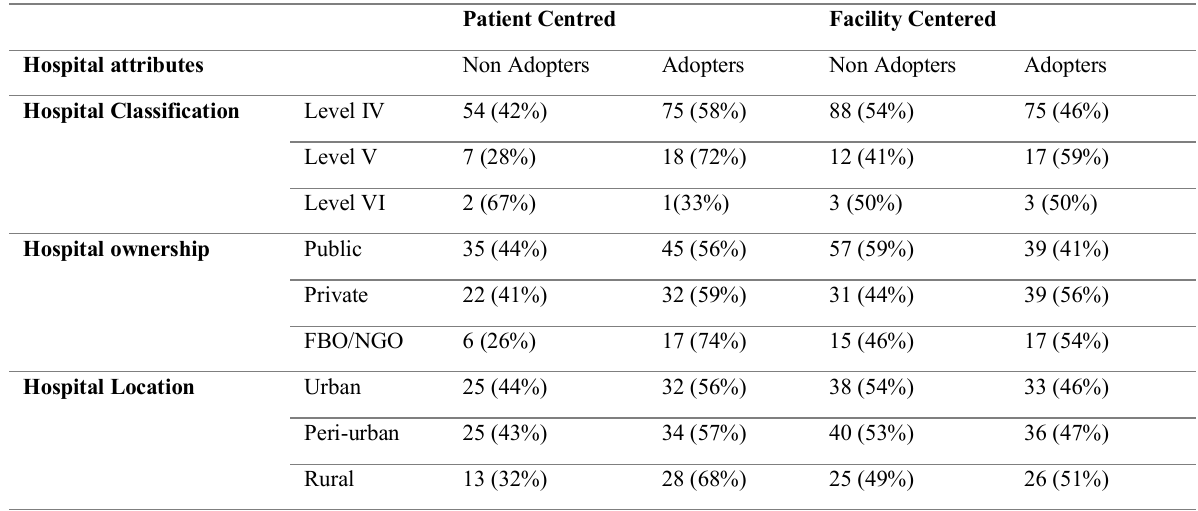
Table 4: Distribution of adoption status by level of hospital, ownership and geographical